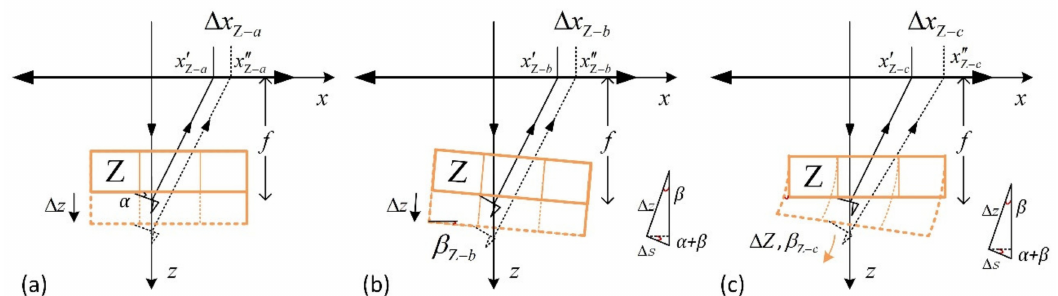
Figure 4. Three types of installation and extension of the Z-scanner. Optical diagram under ideal conditions ( a ), obliquely installation ( b ) and with distorted expansion trajectory ( c